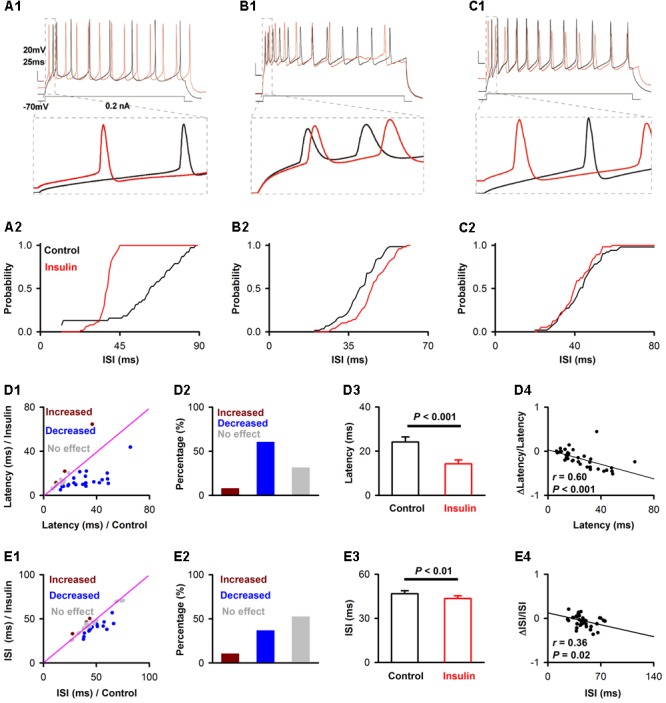
Insulin modulates the first latency and ISI of pyramidal neurons in current-evoked APs. (A1,B1,C1) Raw traces showing a depolarizing step of 0.2 nA was repeated in the control condition (black trace) and during insulin (red trace), under current-clamp mode. The bottom panel shows the enlarged time windows of the raw traces within dashed boxes in the top panel. (A2,B2,C2) Cumulative probability of the ISI of APs in control condition (black) and during insulin (red) for the representative neurons shown in (A1,B1,C1), respectively. Insulin significantly decreases ISI (A2, within-cell Kolmogorov–Smirnov test, n = 38 and 62 ISIs for control and insulin, respectively, P < 0.001), increases ISIs (B2, n = 59 and 49, P = 0.003) or causes no significant effect (C2, n = 51 and 56, P = 0.34) on the three representative neurons. (D1,E1) Comparison of the current-evoked latency (D1)/ISI (E1) of APs between the control condition and during insulin for all 38 neurons. Dark red, latency/ISI during insulin is significant longer than control (mean value of latency / ISI during insulin is larger than control with a p-value smaller than 0.05 for a given neuron); blue, latency/ISI during insulin is significant shorter than control (mean value of latency/ISI during insulin is shorter than control with a p-value smaller than 0.05 for a given neuron); gray, no signifiant difference. The pink line shows the diagonal, where latency/ISI in control is equal to insulin. (D2,E2) Percent of neurons showing increased (dark red), decreased (blue), and no significant effect (gray) of insulin on latency (D2) and ISI (E2). (D3,E3) Comparsion of latency [D3, paired t-test, n = 38, t(37) = 4.64, P = 4.23∗e-5]/ISI [E3, paired t-test, n = 38, t(37) = 3.00, P = 0.005] in control and insulin conditions across the group of neurons recorded. The error bars represent mean ± SE. (D4,E4) Relationship between normalized change of latency (D4)/ISI (E4) induced by insulin and the latency/ISI in control condition. The significance of correlation was tested by liner regression, n = 38 for both latency (D4) and ISI (E4), the r and P-values are indicated in the plots.